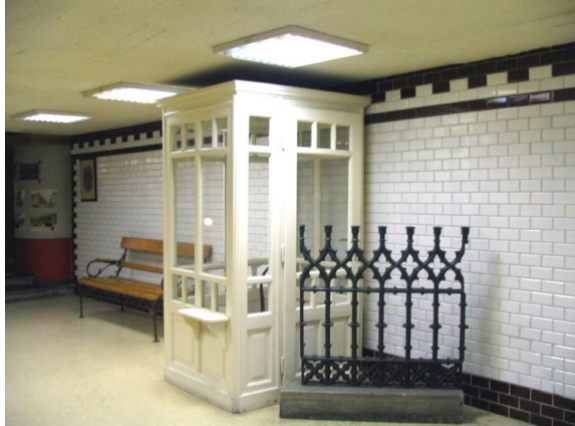
Figure 6. Kossuth Lajos Square five-vault station on Line M2 [2]